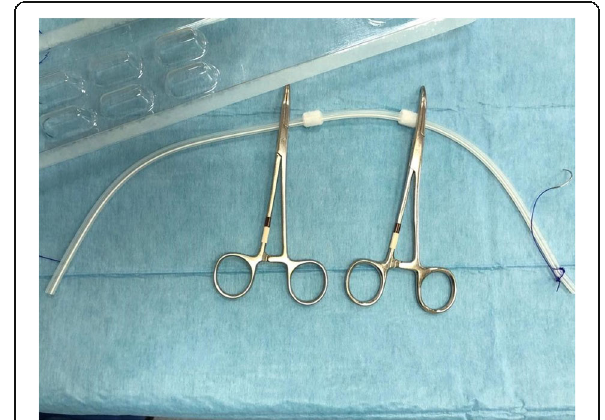
Fig. 1 Preparation of dialysis catheter and tying its tip with V-loc/ STRATAFIX ® size 3/0